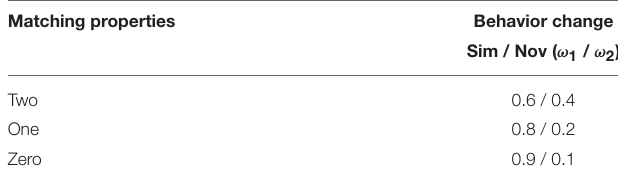
TABLE 2 | Summary of the weightings at which the observed behavior changed preference from familiar to